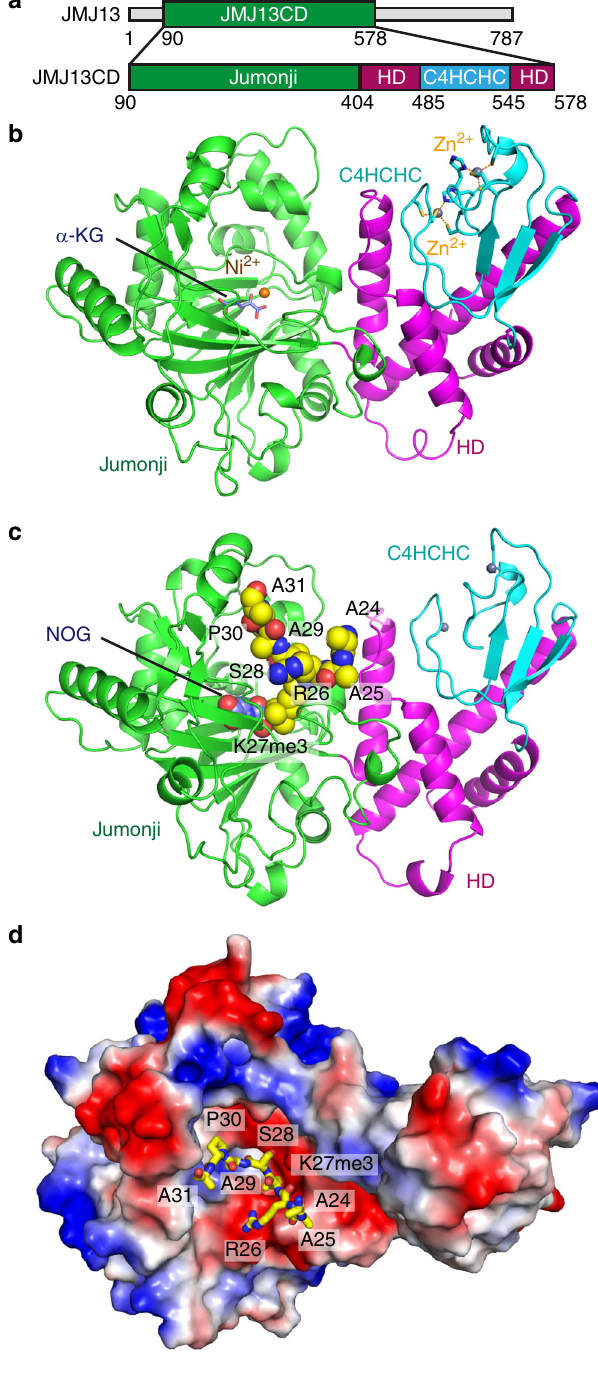
Fig. 2 Structures of JMJ13- α -KG and JMJ13-NOG-H3K27me3 complexes. a A schematic representation of the domain architecture of the JMJ13 (upper panel) and the JMJ13 catalytic domain construct used in crystallization (lower panel). b Overall structure of JMJ13CD- α -KG complex in ribbon representation with the jumonji, helical, and zinc fi nger domains colored in green, magenta and cyan, respectively. The α -KG, nickel ion and zinc ions are shown in stick, orange ball, and silver balls, respectively. The zinc coordination residues are highlighted in stick representation. c Overall structure of JMJ13CD-NOG-H3K27me3 peptide complex with JMJ13 in ribbon and NOG and H3K27me3 peptide in space- fi lling representations, respectively. d An electrostatics surface view of JMJ13CD in complex with the H3K27me3 peptide in stick representation showing that the peptide fi ts into a negatively charge pocket of JMJ13CD. CD catalytic domain,